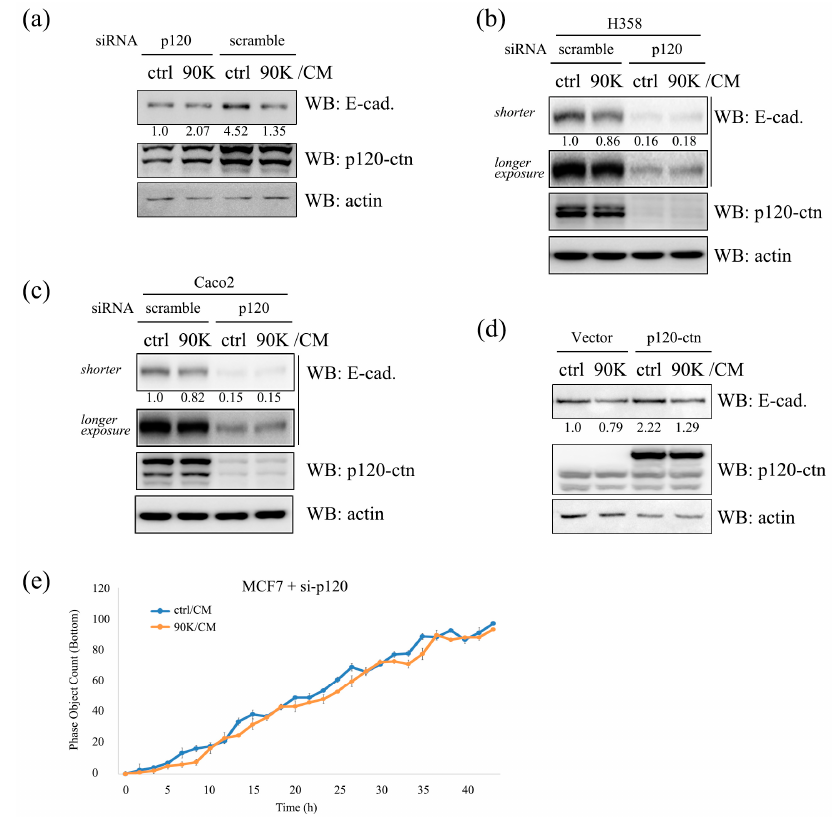
Figure 7. p120-Catenin plays a pivotal role in 90K-induced regulation of E-cadherin level and cell invasion. ( a – c ) p120-Catenin-silencing suppressed the downregulation of E-cadherin by 90K/CM. Subconfluent 293T ( a ), H358 ( b ), and Caco2 ( c ) cells transfected with either scramble or p120-catenin small interfering RNA (siRNA) were treated with ctrl/CM or 90K/CM for 16 h and immunoblotted for E-cadherin, p120-catenin, and actin; ( d ) p120-Catenin overexpression did not affect the downregulation of E-cadherin by 90K conditioned media (90K/CM). Subconfluent 293T cells transfected with mock or GFP-p120-catenin 1A were treated with ctrl/CM or 90K/CM for 16 h and immunoblotted for E-cadherin, p120-catenin, and actin. Actin was used as a loading control. Relative values of E-cadherin/actin ratio in triplicate experiments are shown below the E-cadherin panel; ( e ) Invasive potential was not affected by 90K in p120-catenin-silenced cells. Invasion assay was performed with MCF7 cells transfected with p120-catenin siRNA, and subconfluently plated cells were treated with ctrl/CM or 90K/CM. Invaded cells at the bottom of the transwell chamber were monitored using a live-cell imaging device (IncuCyte) with real-time check for the subconfluency of the upper chamber cells, and time-course analyses of the invaded cell number are shown. Values are presented as mean ± SEM. Significant differences between the groups were not found.